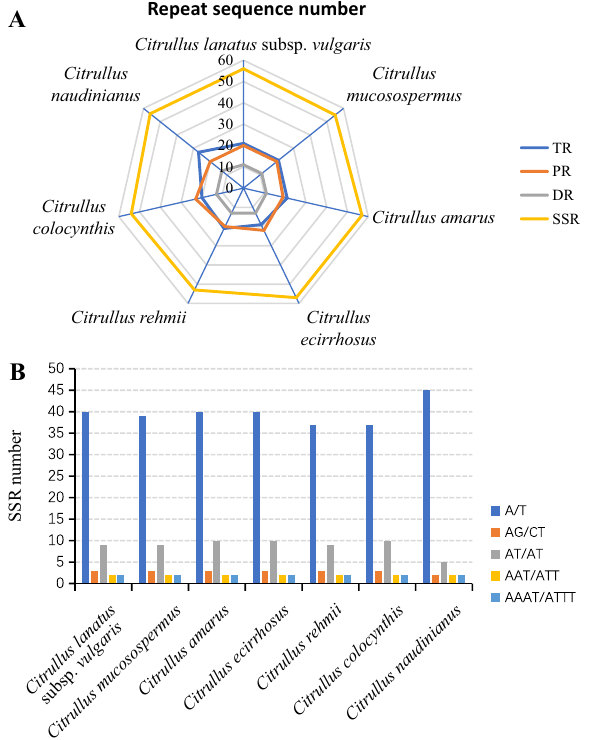
Figure 4. Different repeat sequence number showed in Radar-plot ( A ), Number of SSRs and types detected in the seven CPGs of Citrullus ( B ).